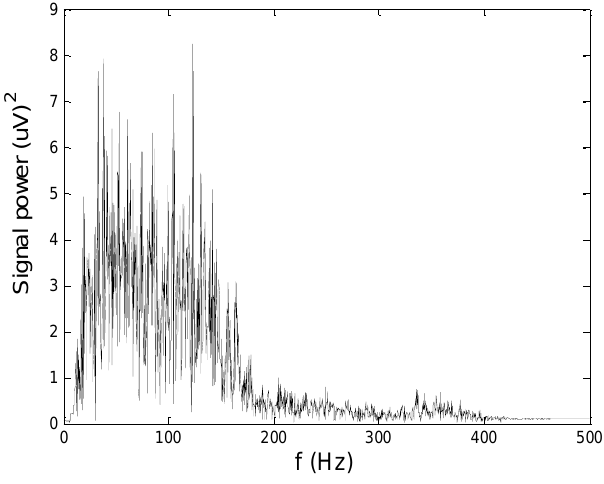
Figure 12. Power spectrum of the simulated artificial EMG denoised by Daubechies5 wavelet and implementation of the soft sqtwolog